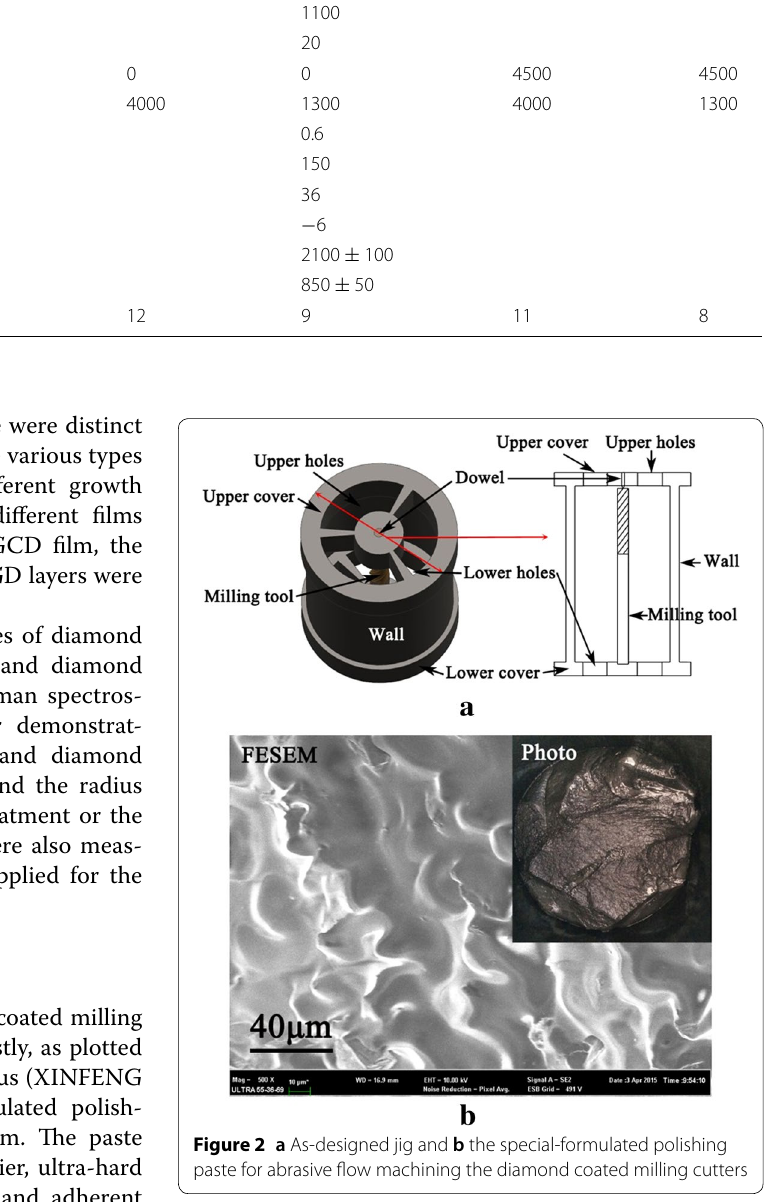
Table 1 Deposition parameters for synthesizing typical types of mono-layer diamond films Nucleation